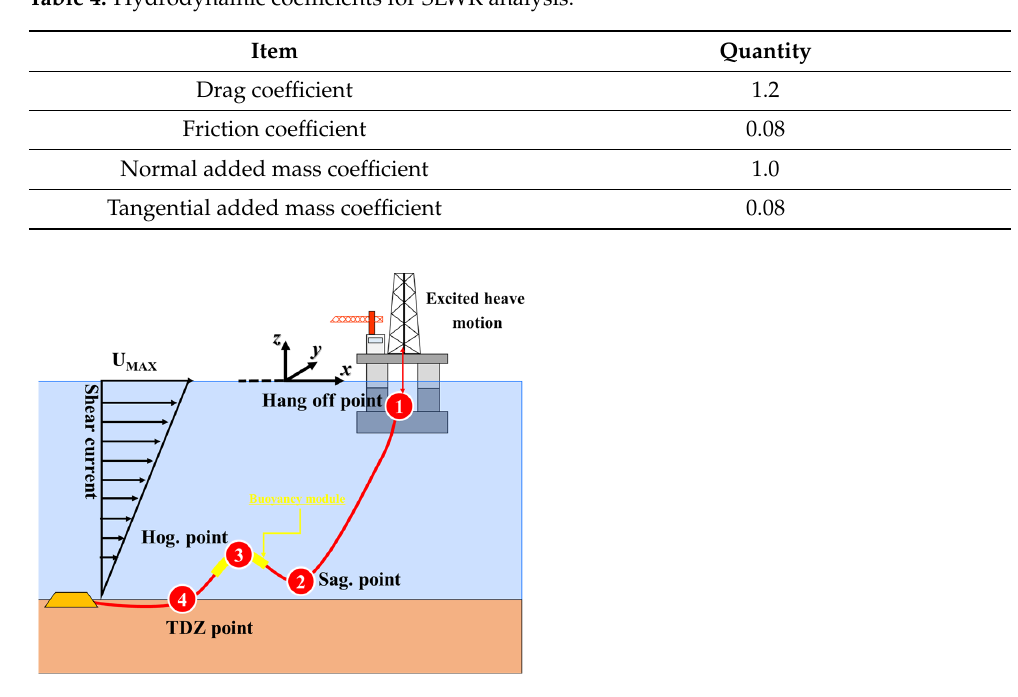
Figure 10. Schematic diagram of static and dynamic analysis of SLWR with